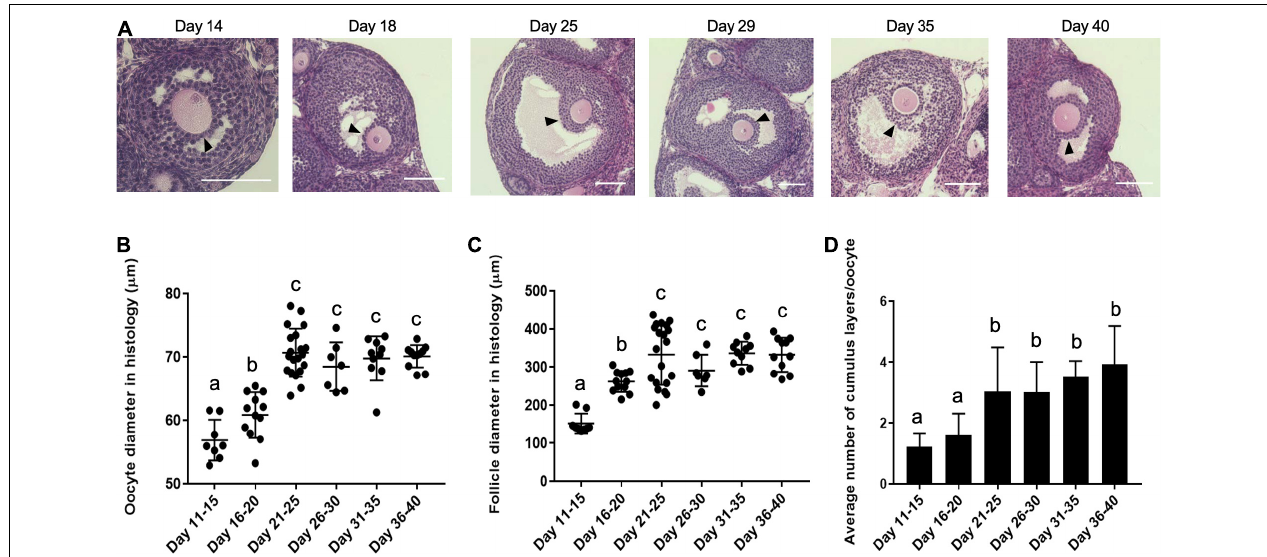
FIGURE 5 | Histological analysis demonstrates that oocytes originate from follicles with increasing diameter and attain more cumulus cell layers as puberty progresses. (A) Representative histology sections of antral follicles in mice at different ages across the pubertal transition that contain oocytes of the approximate size as those that were isolated directly from the ovary ( Figure 2C ). The arrowheads highlight the cumulus cell layers. The scale bars are 100 µ m. (B) The average oocyte diameter in antral follicles in ovarian histological sections in the different age cohorts are shown ( n = 68 oocytes within ovaries from at least 2 mice per age cohort analyzed, p < 0.01). (C) The average follicle diameter of the oocytes measured in (B) was plotted ( n = 68 follicles within ovaries from at least 2 mice per age cohort analyzed, p < 0.01). (D) The average number of cumulus cell layers surrounding the oocytes in the follicles assessed in (B,C) were counted in the